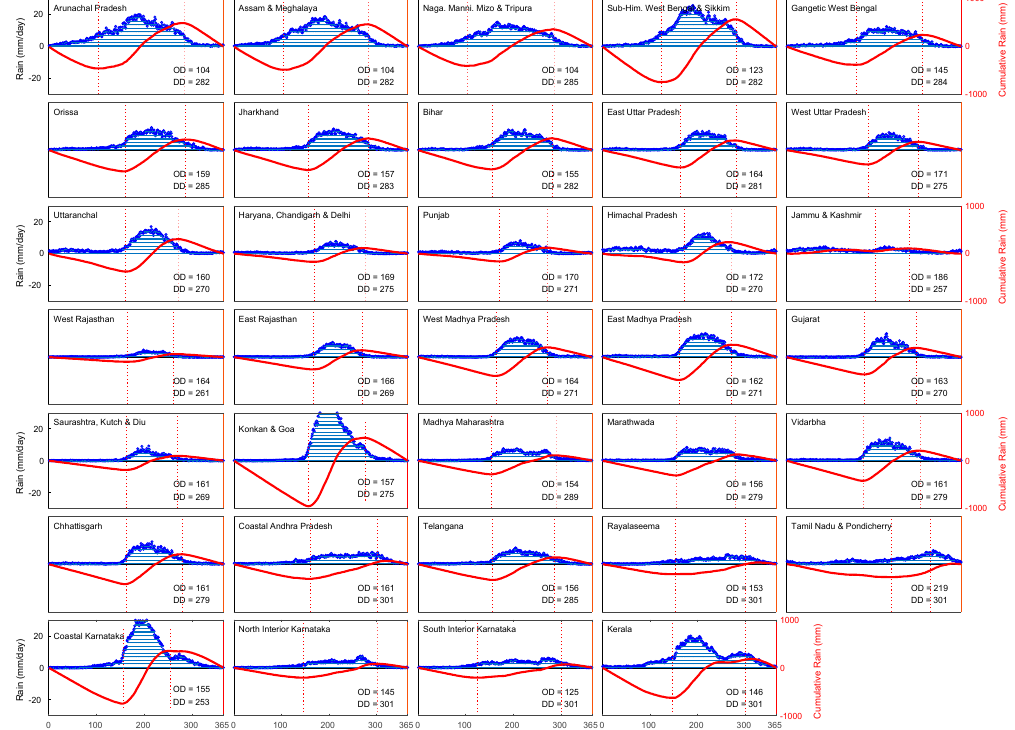
Figure 2. Time series of daily rainfall climatology (IMD) of the 34-meteorological sub-divisions of India (MSDs; blue dots) and the corresponding cumulative daily anomaly curve (red line) with onset (OD) and Demise (DD) dates marked in Julian days. The onset and demise are marked by dotted red lines that mark the inflection points where the slope of the cumulative daily anomaly curve changes.